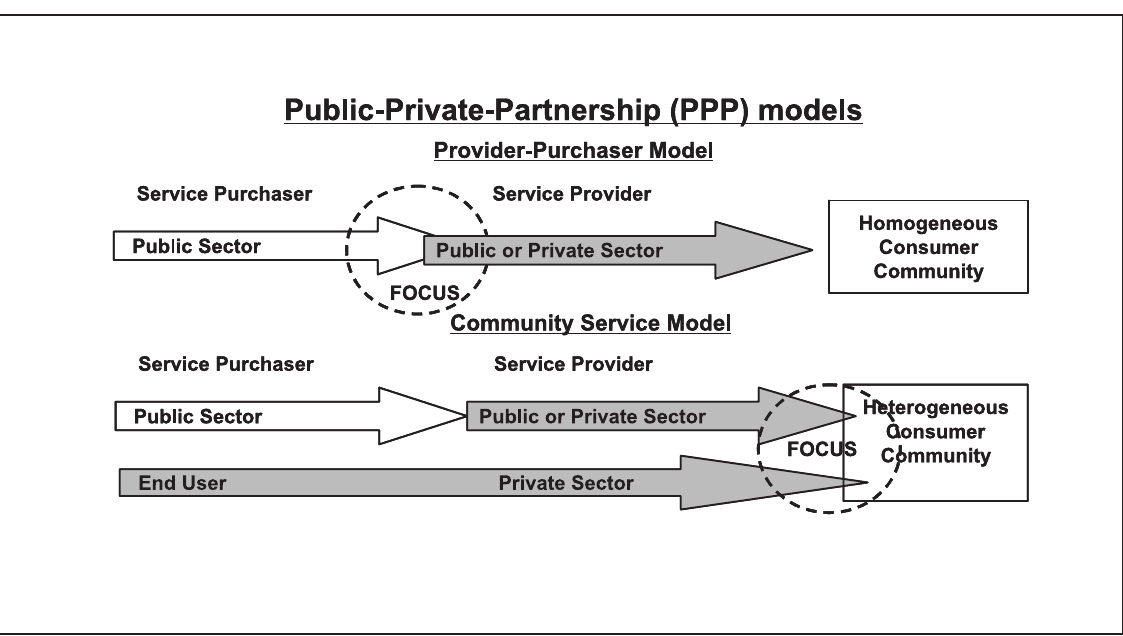
Figure 1. From Purchaser-provider model to Community service model